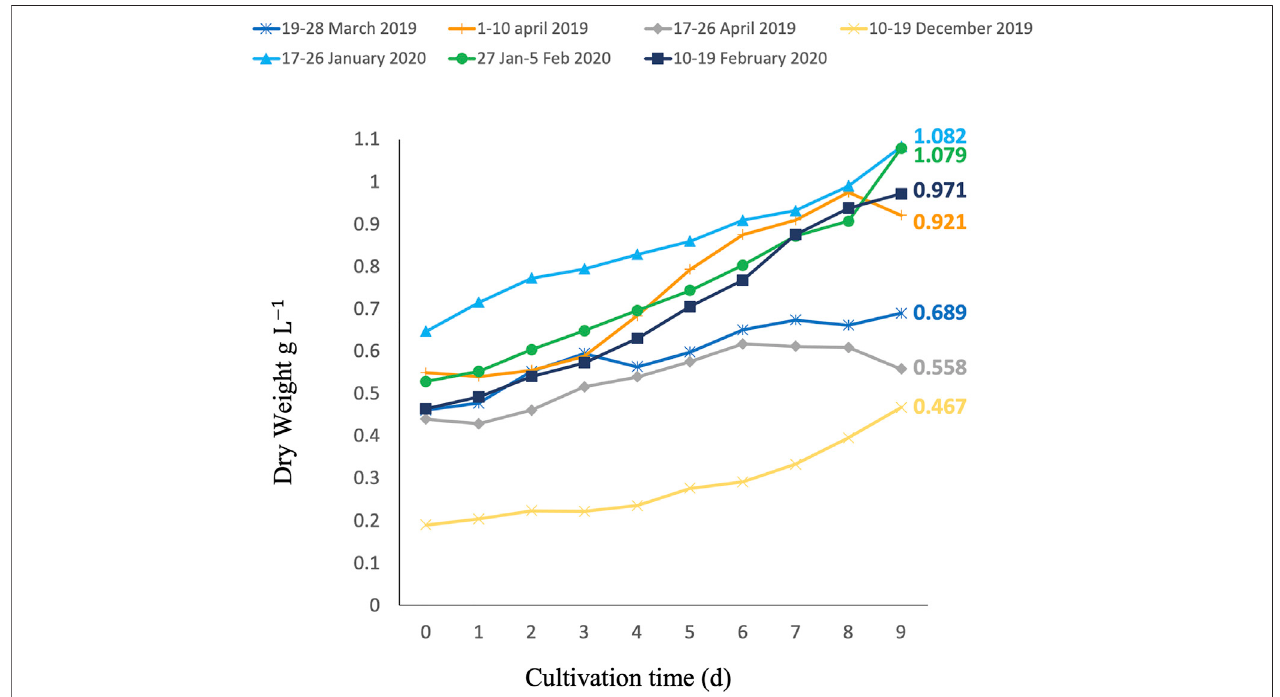
FIGURE 3 | Box plot of the temperature for each period. Outliers are shown by dots above the maximum. See also Table 2 .